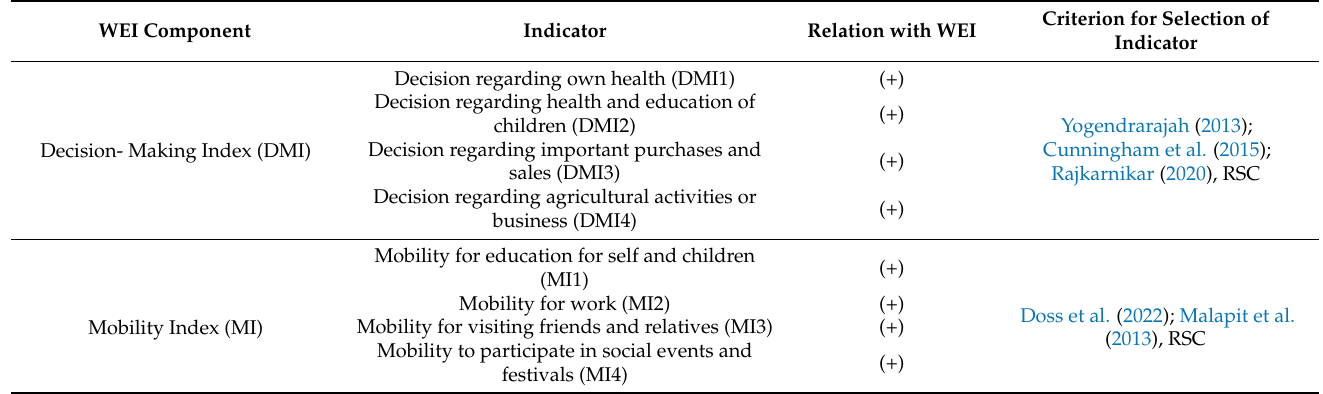
Table 1. WEI components, indicators, indicators’ relation to empowerment, and criteria for selection of indicators. RSC and EJ refer to Relevance to Study Context and Experts’ Judgement,